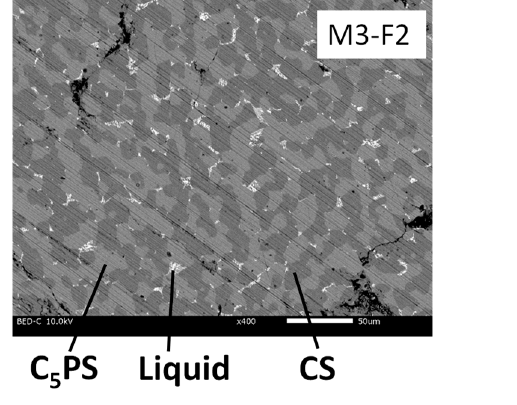
Figure 9. SEM image of M3-F2 (2mass% Fe 2 O 3 ) ( left ) and the phase composition projected on the isothermal section of the CaO-SiO 2 -P 2 O 5 ternary phase diagram at 1573 K ( right ).